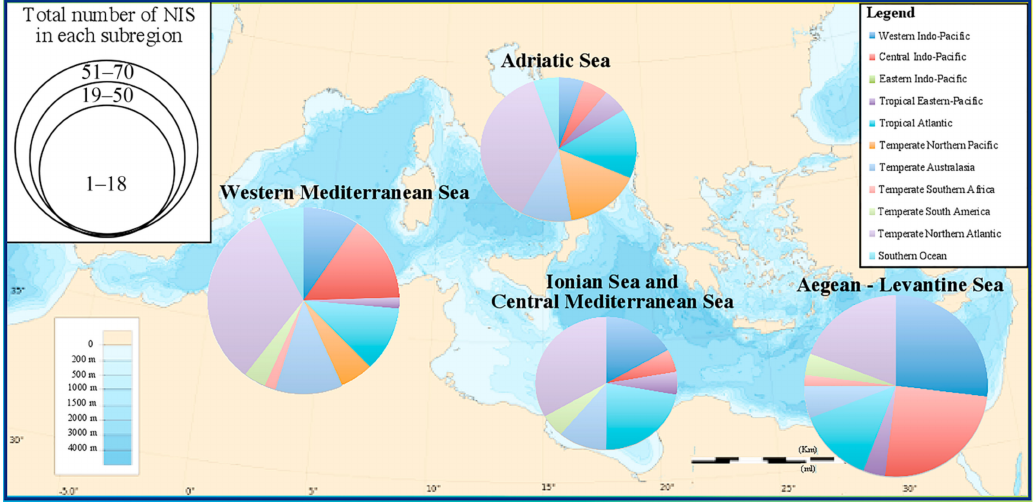
Figure 1. Proportion of the major native distribution ranges of CC NIS (following Spalding et al. [42] for biogeographic realms classifications) in the Mediterranean subregions. The size of each pie chart represents the total number of NIS primarily introduced in a